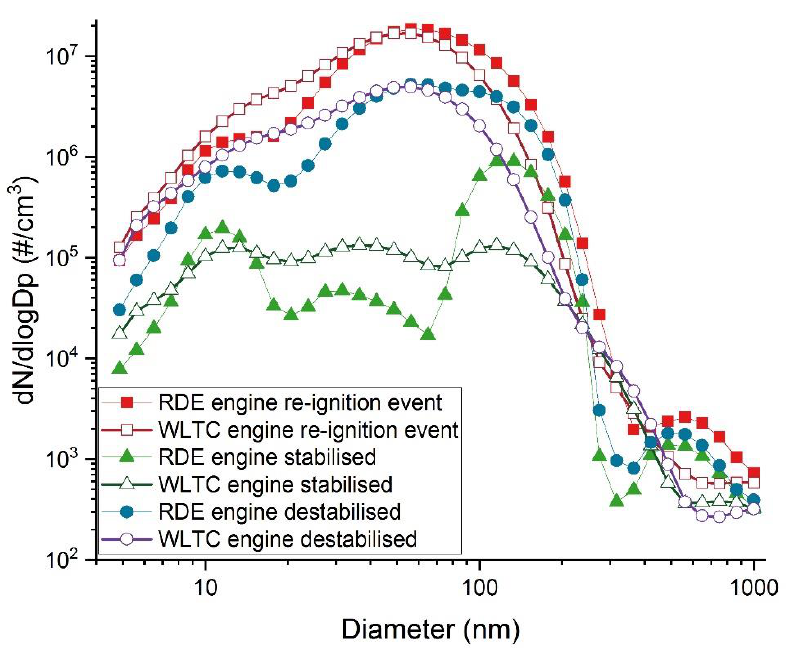
Figure 11. Average WLTC and RDE PNSD during engine re-ignition event, engine stabilised and engine destabilised states.